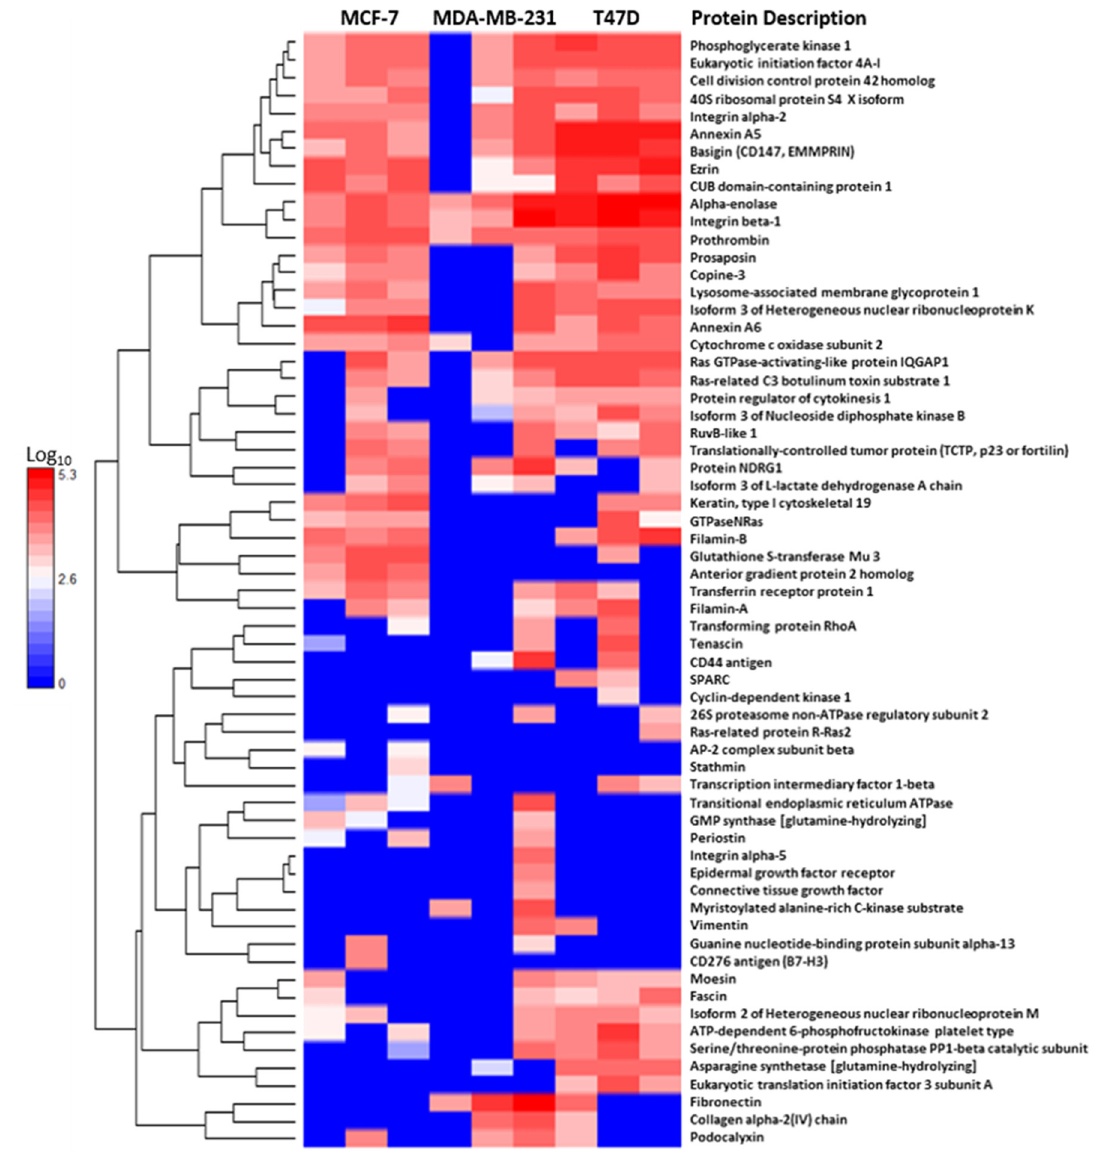
Figure 4. Heatmaps of the proteins associated with metastasis in cancer. Each cell represents the average of the technical replicates for one biological replicate for each of the proteins identified in the EVs derived from MCF-7, MDA-MB-231 and T47D cells. Hierarchical clustering groups the proteins with similar abundance profiles across the EV samples. The heatmaps and clusters were generated using DanteR software on a log 10 scale.